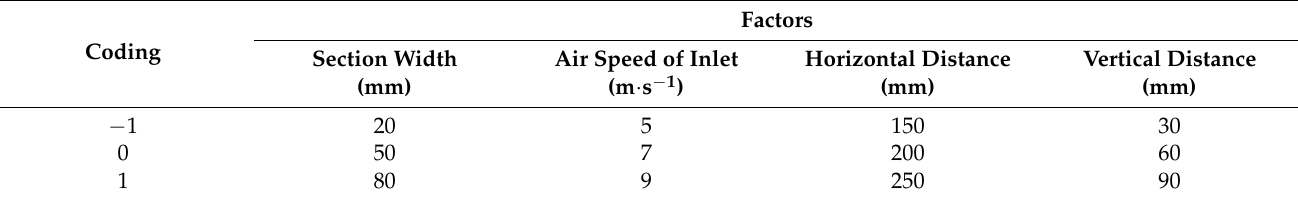
Table 3. Factors coding.